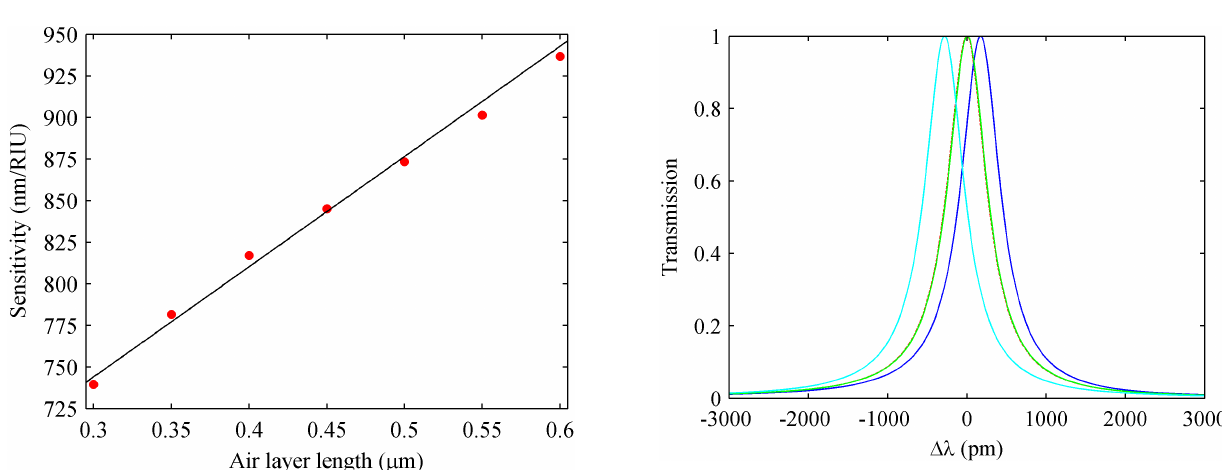
Figure 7. Sensitivity as a function of the air layer length for d Si = 0 . 32µm. The cavity length is changed from 0.725 to 0.825µm in order to keep the cavity wavelength at 1.55µm. The sensitivity changes almost linearly with d Air .